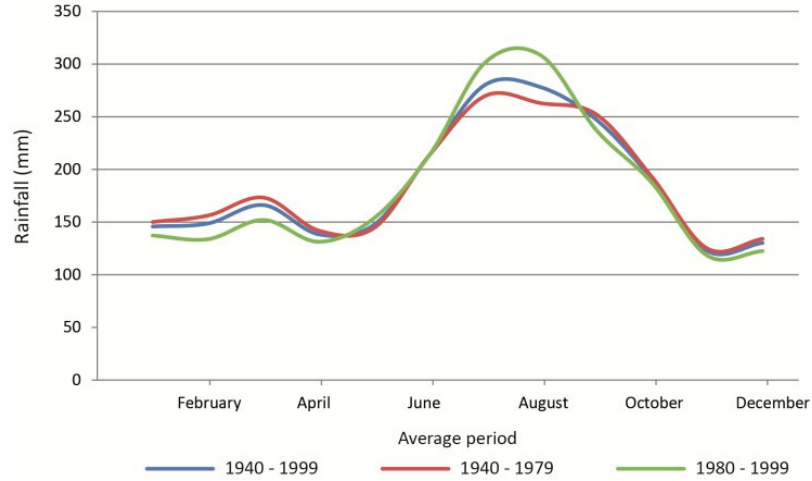
Figure 6. Mean monthly rainfall regime on the Congo River Basin over two different hydroclimatic periods (1940–1979 versus 1980–1999) and over the whole 1940–1999 period.